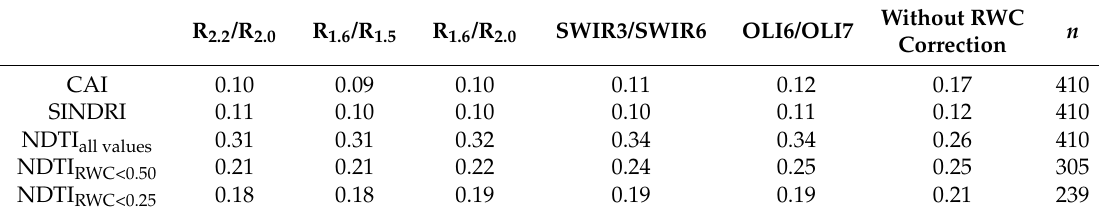
Table 8. RMSE of the fraction of residue cover observed in the field and estimated from the multivariate linear model from the laboratory experiment (Table 4) based on CAI, SINDRI and NDTI, when the relative water content was estimated from various spectra water indices based on narrow or broad bands extracted from the reflectance spectra measured in the field. The RMSE for NDTI considering only data with RWC < 0.25 or RWC < 0.50 are also included. Without RWC n R 2.2 /R 2.0 R 1.6 /R 1.5 R 1.6 /R 2.0 SWIR3/SWIR6 OLI6/OLI7 Correction CAI 0.10 0.09 0.10 0.11 0.12 0.17 410 SINDRI 0.11 0.10 0.10 0.10 0.11 0.12 410 NDTI all values 0.31 0.31 0.32 0.34 0.34 0.26 410 NDTI RWC<0.50 0.21 0.21 0.22 0.24 0.25 0.25 305 NDTI RWC<0.25 0.18 0.18 0.19 0.19 0.19 0.21